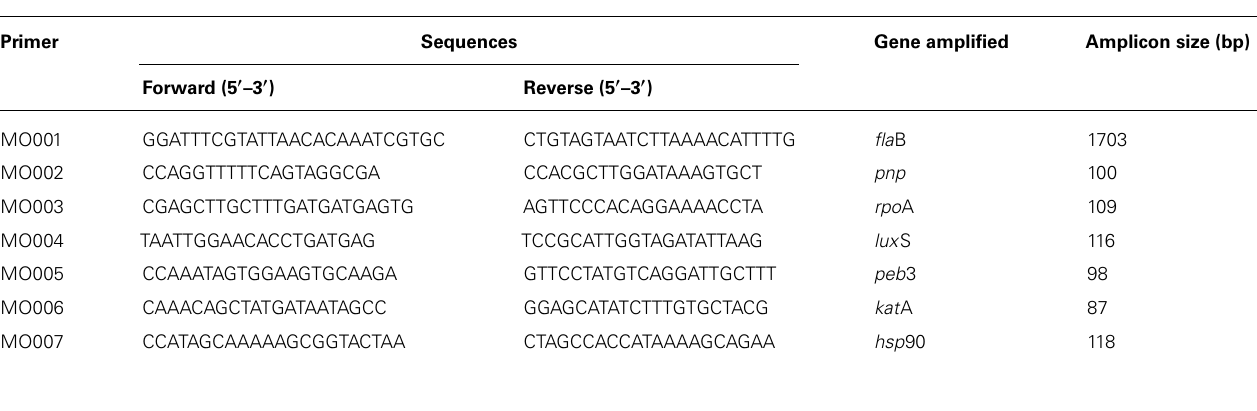
Table 2 | Primers used in this